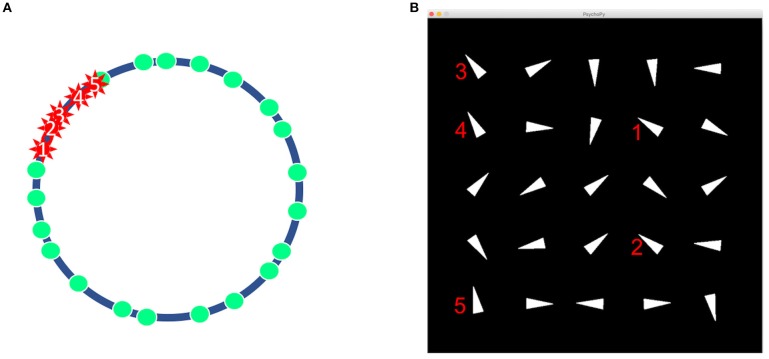
The design of a trial in the interactive module. (A) 20 non-mines and 5 mines represented as points on a circle. (B) Example of a trial as seen by participant. Notice how the five identified marks in (A) are displayed as triangles in an orientation in (B).